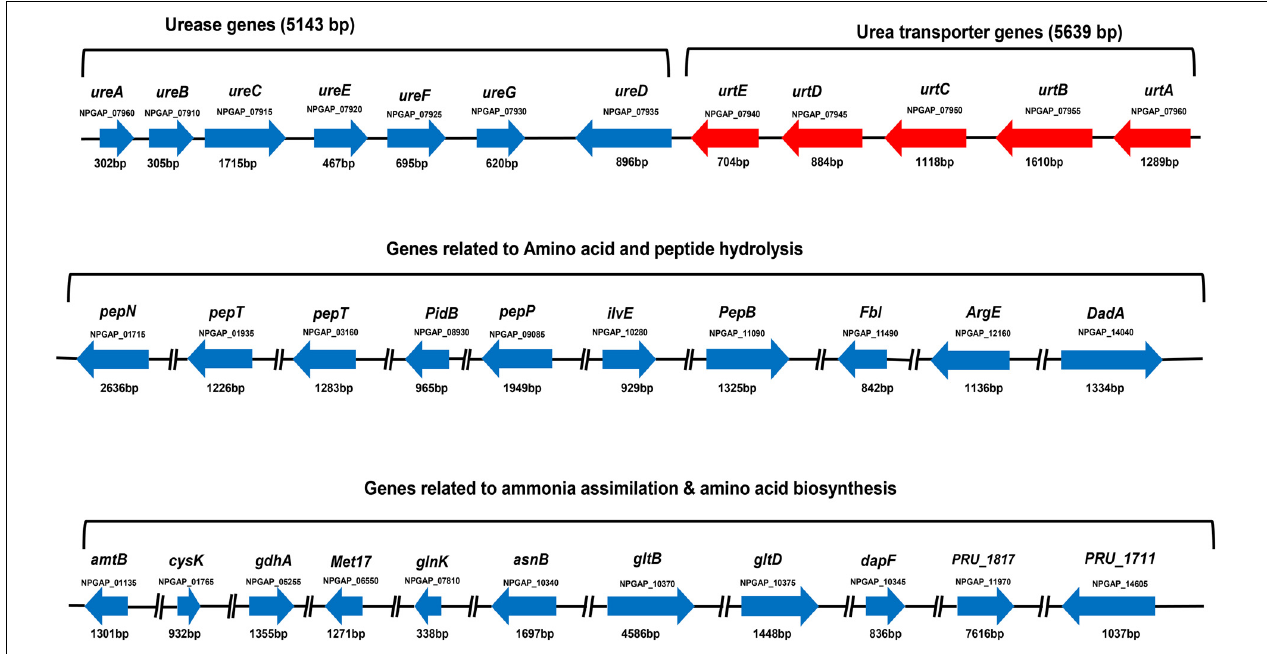
FIGURE 3 | Gene clusters for urea-nitrogen hydrolysis and transportation; gene groups for amino acid and peptide degradation; and ammonia assimilation and amino acid biosynthesis. The code written under the gene represents locus tag. The solid line between the genes indicates the genes on the same cluster and the broken line indicates the genes found in different clusters.